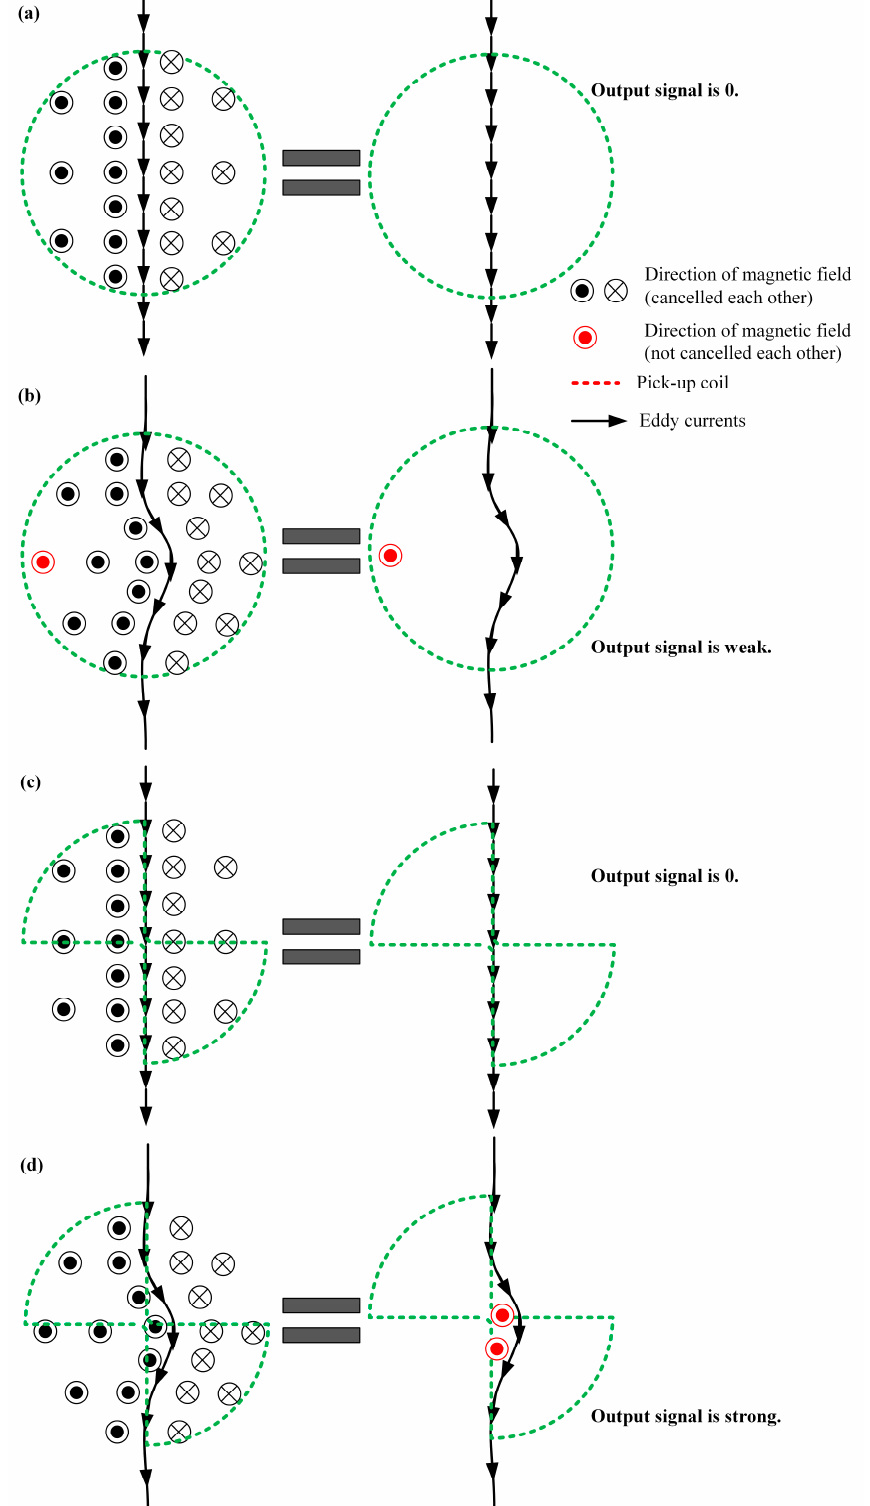
Figure 2. Eddy current disturbance: ( a ) no disturbance in the circular pickup coil, ( b ) disturbance in the circular pickup coil, ( c ) no disturbance in the two-circular sectors pickup coil, ( d ) disturbance in the two-circular sectors pickup